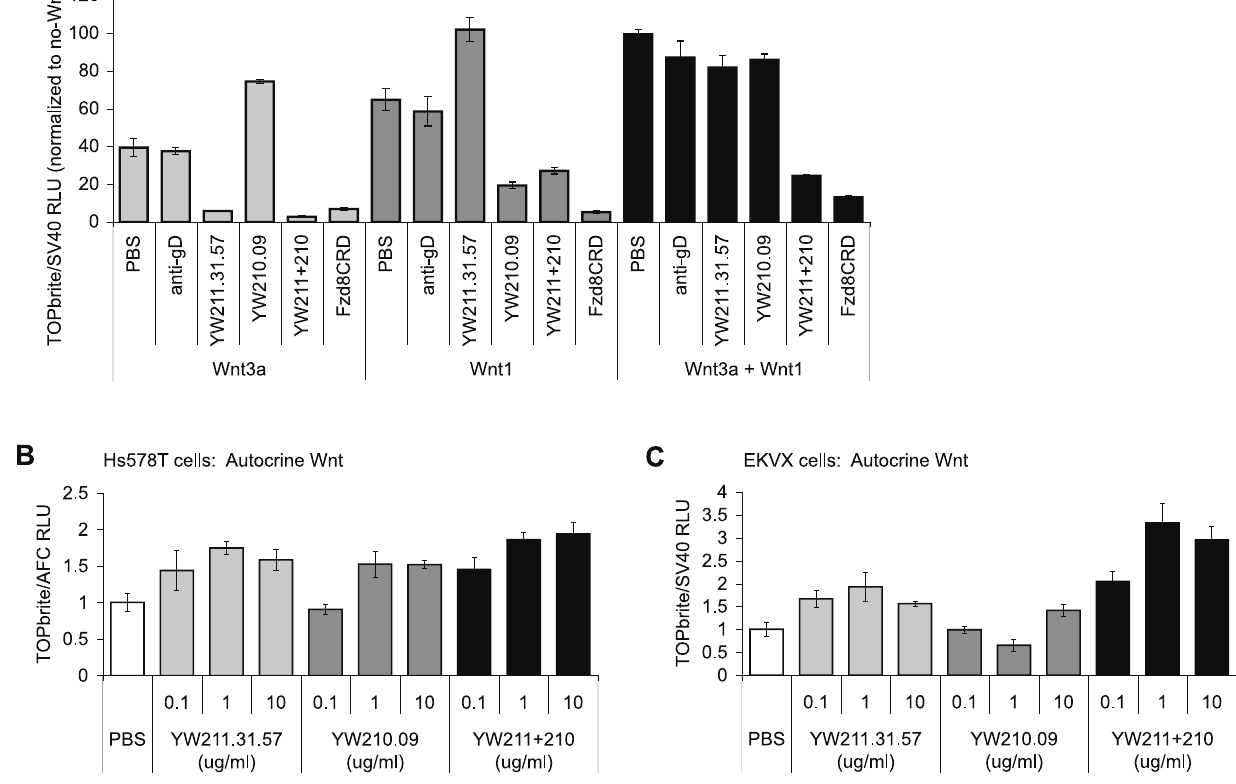
Figure 5. LRP6 antibody combinations can inhibit signaling induced by multiple Wnt isoforms. (A) The combination of YW211.31.57 and YW210.09 antibodies inhibits signaling in HEK293 cells stably integrated with Wnt luciferase reporter that have been transfected with expression constructs for either Wnt3a, Wnt1, or both Wnt3a and Wnt1. All antibodies and proteins were used at 10 m g/ml each. Treatment with either YW211.31.57 or YW210.09 antibody does not significantly change the level of signaling induced by the combination of both Wnt isoforms, possibly because signaling by one Wnt is antagonized while the other Wnt is potentiated. (B–C) As with individual antibody treatments, the combination of YW211.31.57 and YW210.09 antibodies potentiates autocrine Wnt signaling in Hs578T (B) or EKVX (C)